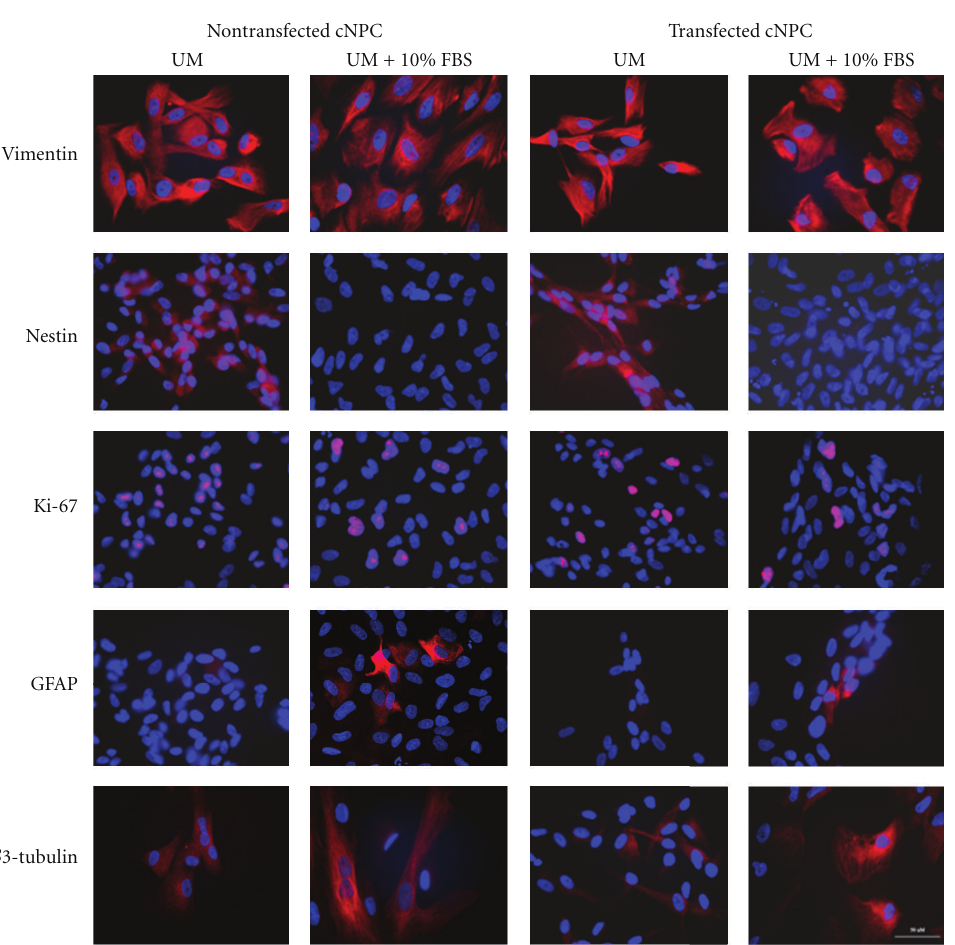
Figure 6: Expression profiles of marker genes in transfected cNPCs by ICC. Gene expression profiles of several neural progenitor, cell proliferation, and di ff erentiation markers were evaluated by immunocytochemistry (ICC). Transfected cNPCs were cultured in UM, or UM containing 10% FBS, for 5 days and then immunolabeled with di ff erent epitope-specific antibodies to detect the markers